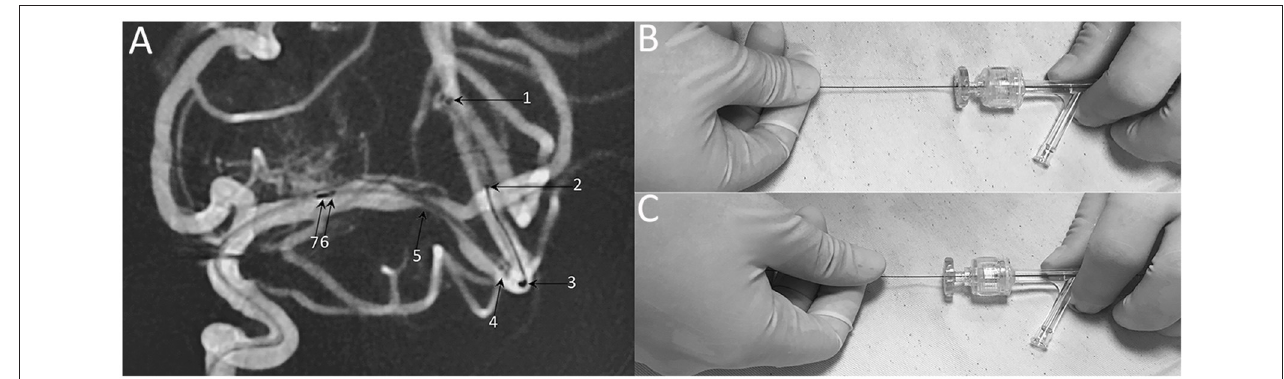
FIGURE 6 | Technical note of Neuroform EZ stent deployment. (A) Representative DSA image of stent deploying, demonstrating the radiopaque markers of 1: XT-27 microcatheter tip, 2: distal tip of the delivery wire, 3: distal bumper, 4: distal stent markers, 5: stenosis 6: stent proximal markers, 7: proximal bumper. (B) When the stent was ready to be deployed, holding the stent delivery wire at a sufficient distance (about 8-10cm) from the RHV. (C) Insufficient distance may cause unnecessary hand movement and poor stent apposition.